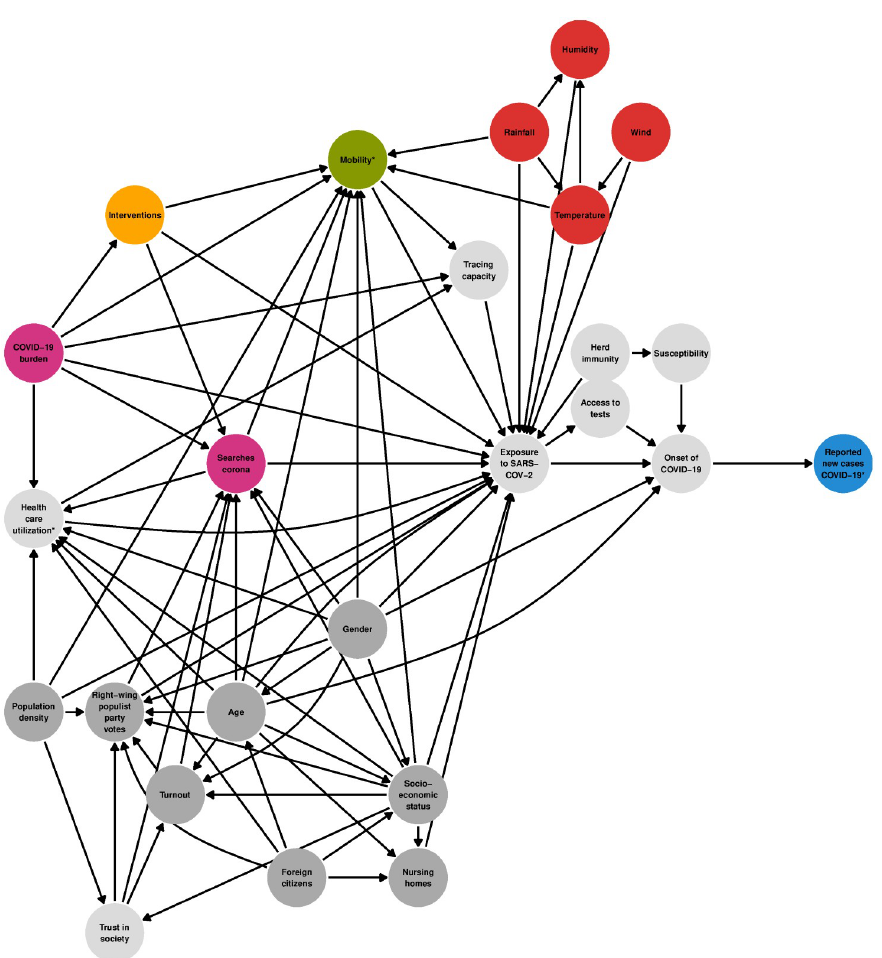
Fig 1. DAG of determinants of reported COVID-19 cases on the district level. Unobserved variables are light gray, variables marked with an asterisk ( � ) are confounded by weekday/holiday.